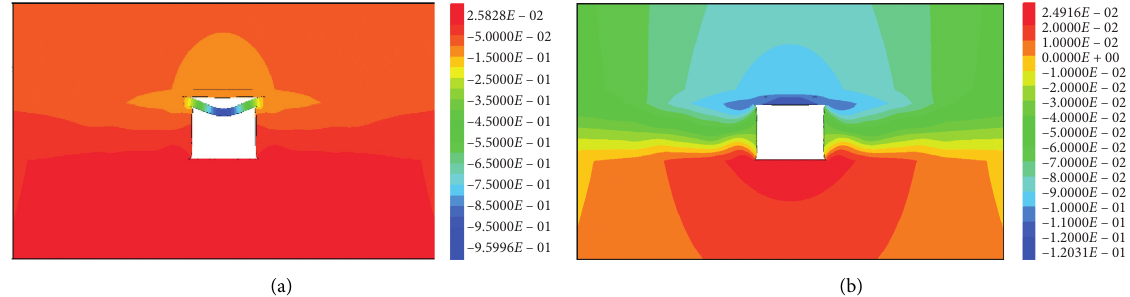
Figure 12: Roof sag of different rock-rock interfacial cohesion: (a) 0.1 MPa and (b) 2 MPa.